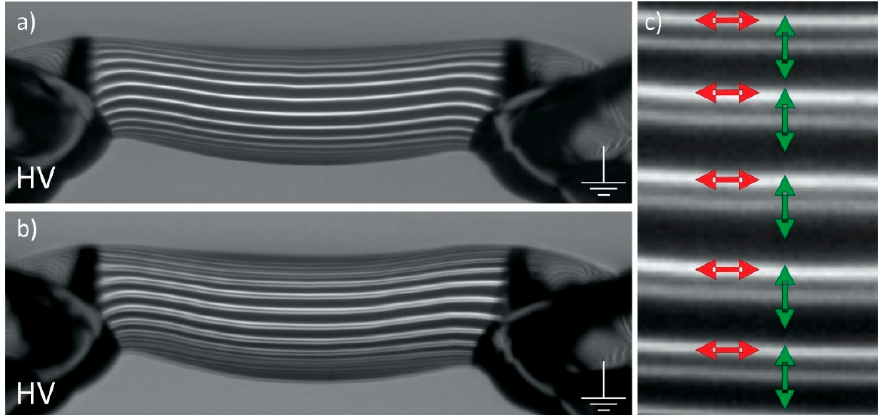
Figure 2. Illustration of the vertical shear. ( a ) Image of the bridge without vertical shear and represents a normal fringe visualization of the bridge and ( b ) a small vertical shear is added so that the two images show a small vertical shift, allowing both the image stemming from the vertical (upper, brighter line) and the horizontal (lower, slightly darker line) polarization, respectively, to simultaneously identified. ( c ) A magnification from ( b ) indicating the two polarization directions. Both the brighter and dimmer line patterns (thus both polarizations) pass through the bridge along the same geometrical path.